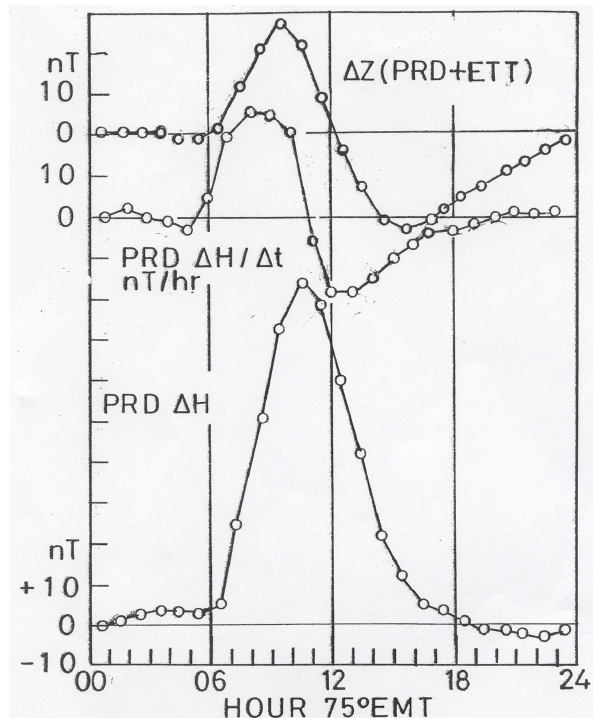
Fig. 5. Yearly mean daily variation of 1H and PRD and 1Z at PRD + 1Z at KOD compared with the temporal gradient of 1H at PRD during the period March 1993–February